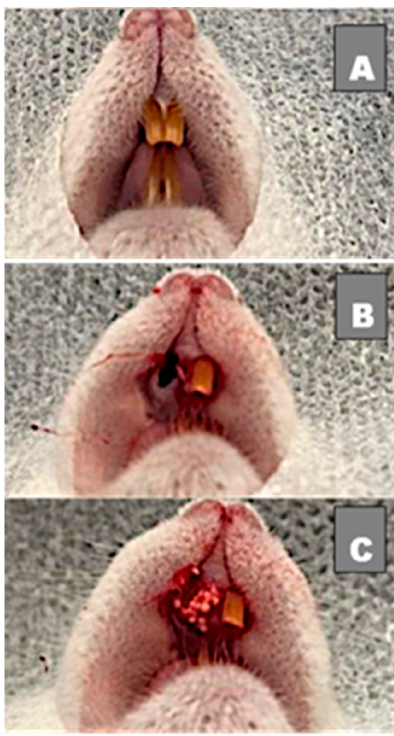
Figure 1. ( A ): Clinical image before surgery with 2 upper incisors; ( B ): Right upper incisor extracted Figure 1. ( A ) Clinical image before surgery with 2 upper incisors; ( B ) Right upper incisor extracted with alveolar bone preserved; ( C ): Socket filled with biomaterial. with alveolar bone preserved; ( C ) Socket filled with